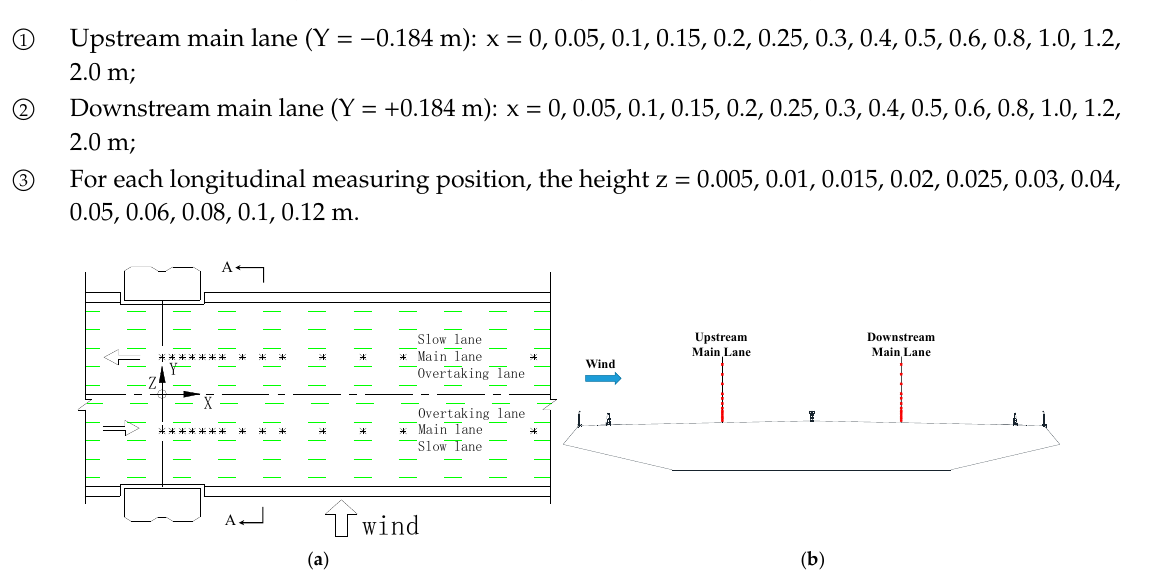
Figure 3. The positions of measuring points. ( a ) Longitudinal measuring point arrangement. ( b )Vertical measuring point arrangement (A-A Section).